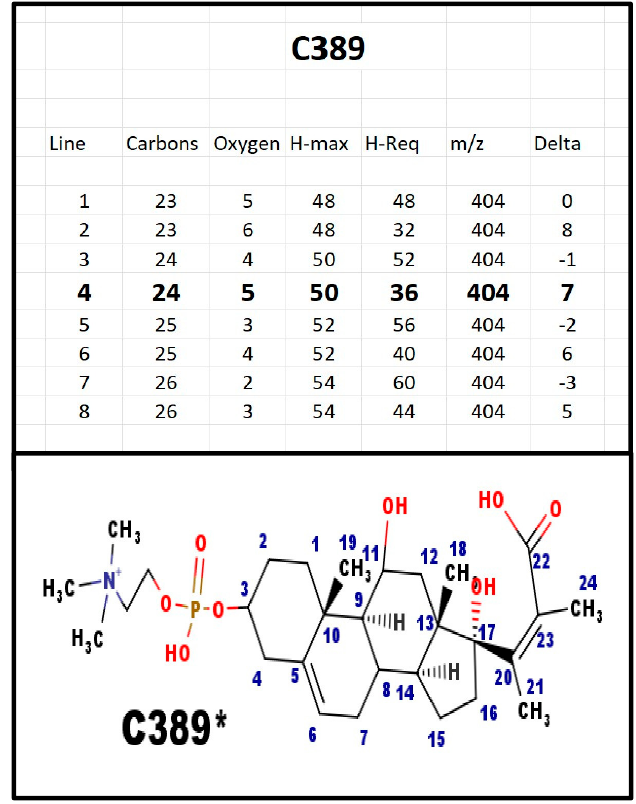
Figure A10. The proposed structures of C389.